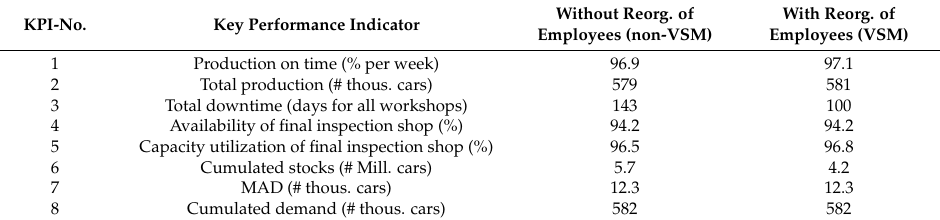
Table 5. Case study 2—Results.